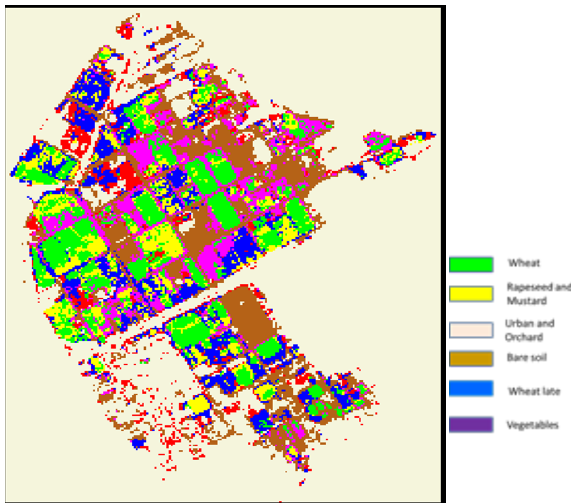
Figure 8. Separability analysis between the classes (above) and classified image obtained by classifying Sentinel-2 imagery using MXL classification (below)